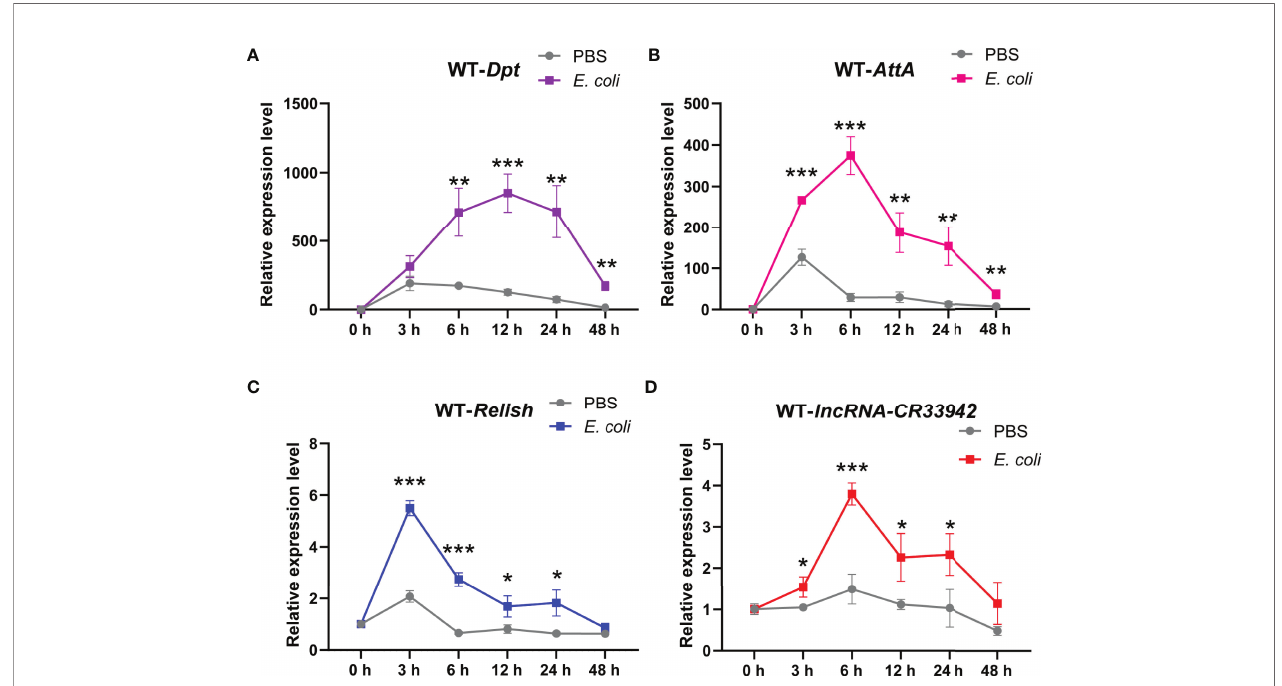
FIGURE 6 | The Relish/ lncRNA-CR33942 /AMPs regulatory axis contributes to the Drosophila Imd immune response. The expression levels of Dpt (A) , AttA (B) , Relish (C) , and lncRNA-CR33942 (D) in wild-type fl ies ( w 1118 ) at different time points (0, 3, 6, 12, 24, and 48 h) after Escherichia coli infection. *P < 0.05; **P < 0.01; ***P < 0.001.